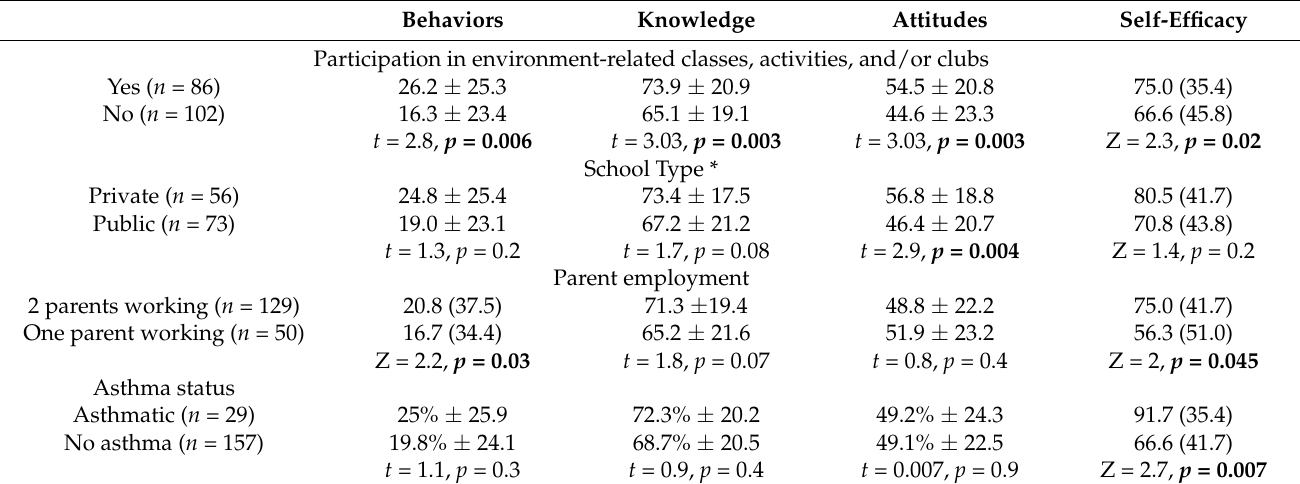
Table 5. Factors associated with Environmental Health Sub-scores in Participants Ages 15–18 Years. Behaviors Knowledge Attitudes